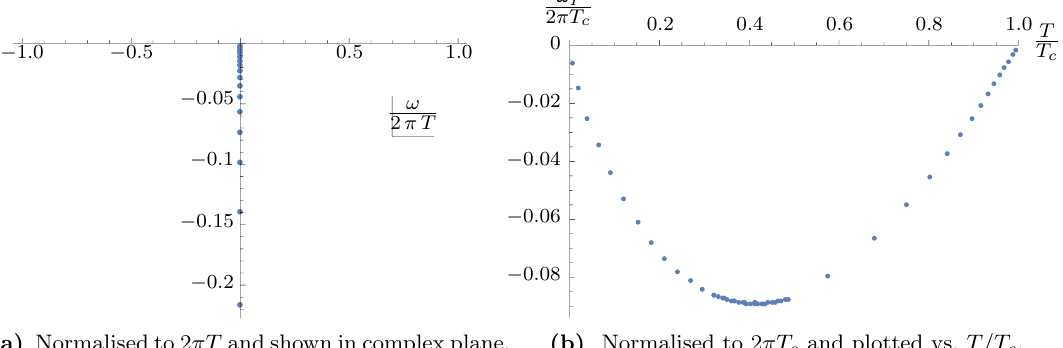
(b) Normalised to 2 (cid:25)T c and plotted vs. T=T c . Figure 8. The lowest QNMs extracted from (cid:12)tting the relaxation behaviour after Gaussian quenches in the condensed phase characterised by 0 : 008 (cid:20) T=T c (cid:20) 1.